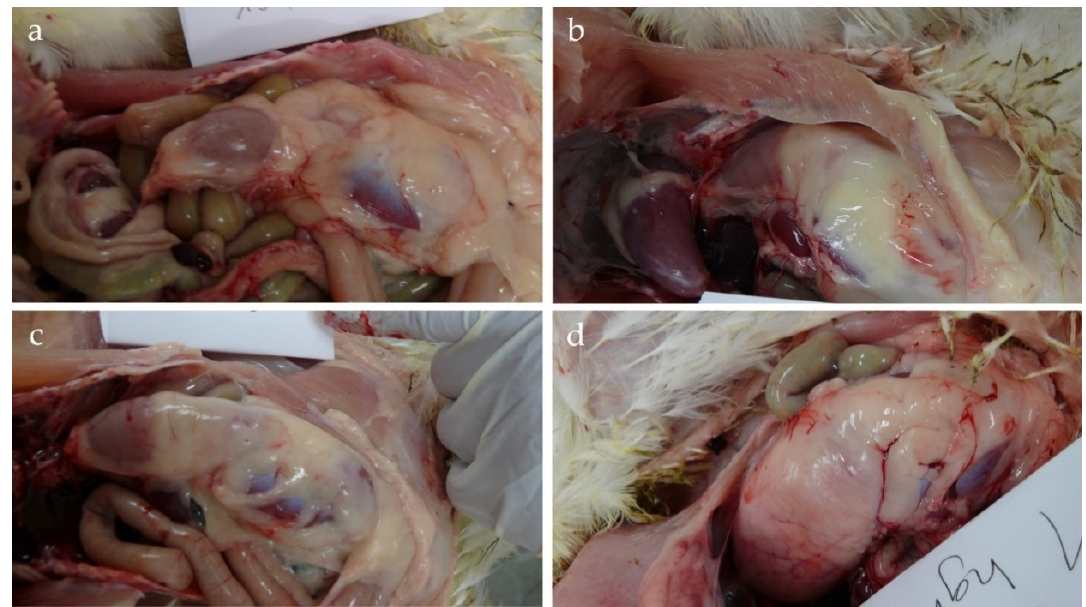
Figure 2. Scoring of Isthmus gastrici : ( a ) Score 0 = anatomically correct; ( b ) 1 = slight dilatation; ( c ) Score 2 = moderate dilatation; ( d ) Score 3 = high dilatation (photo: © Kriewitz/TiHo).